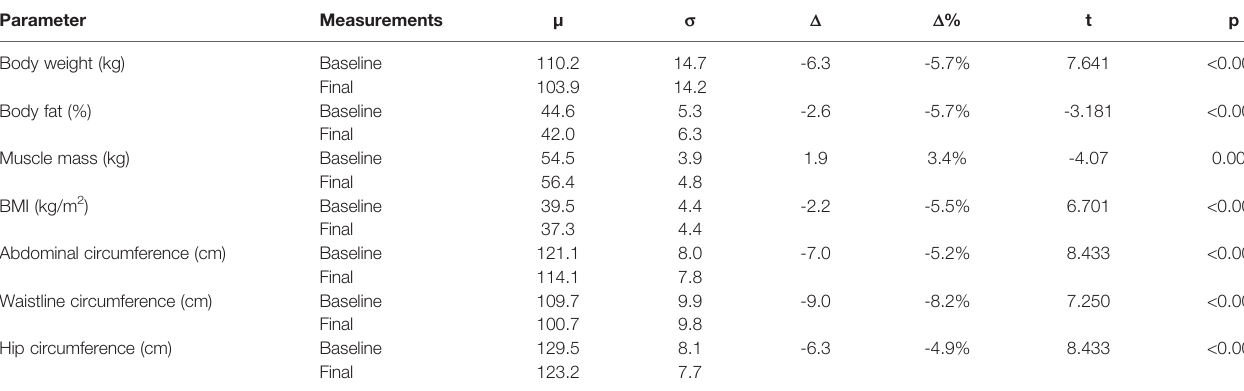
TABLE 6 | Comparison between baseline and fi nal visit measurements of body characteristics and composition. Parameter